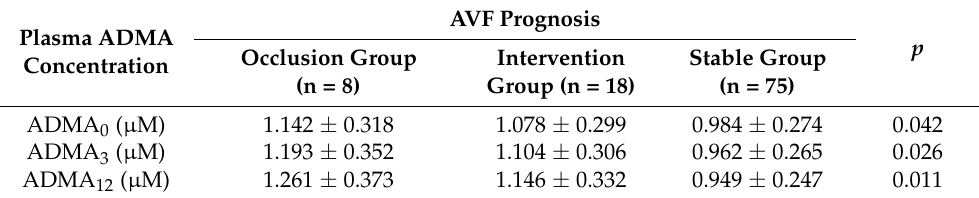
Table 3. Comparison of plasma ADMA concentrations in advanced DKD patients with different AVF prognosis for 12